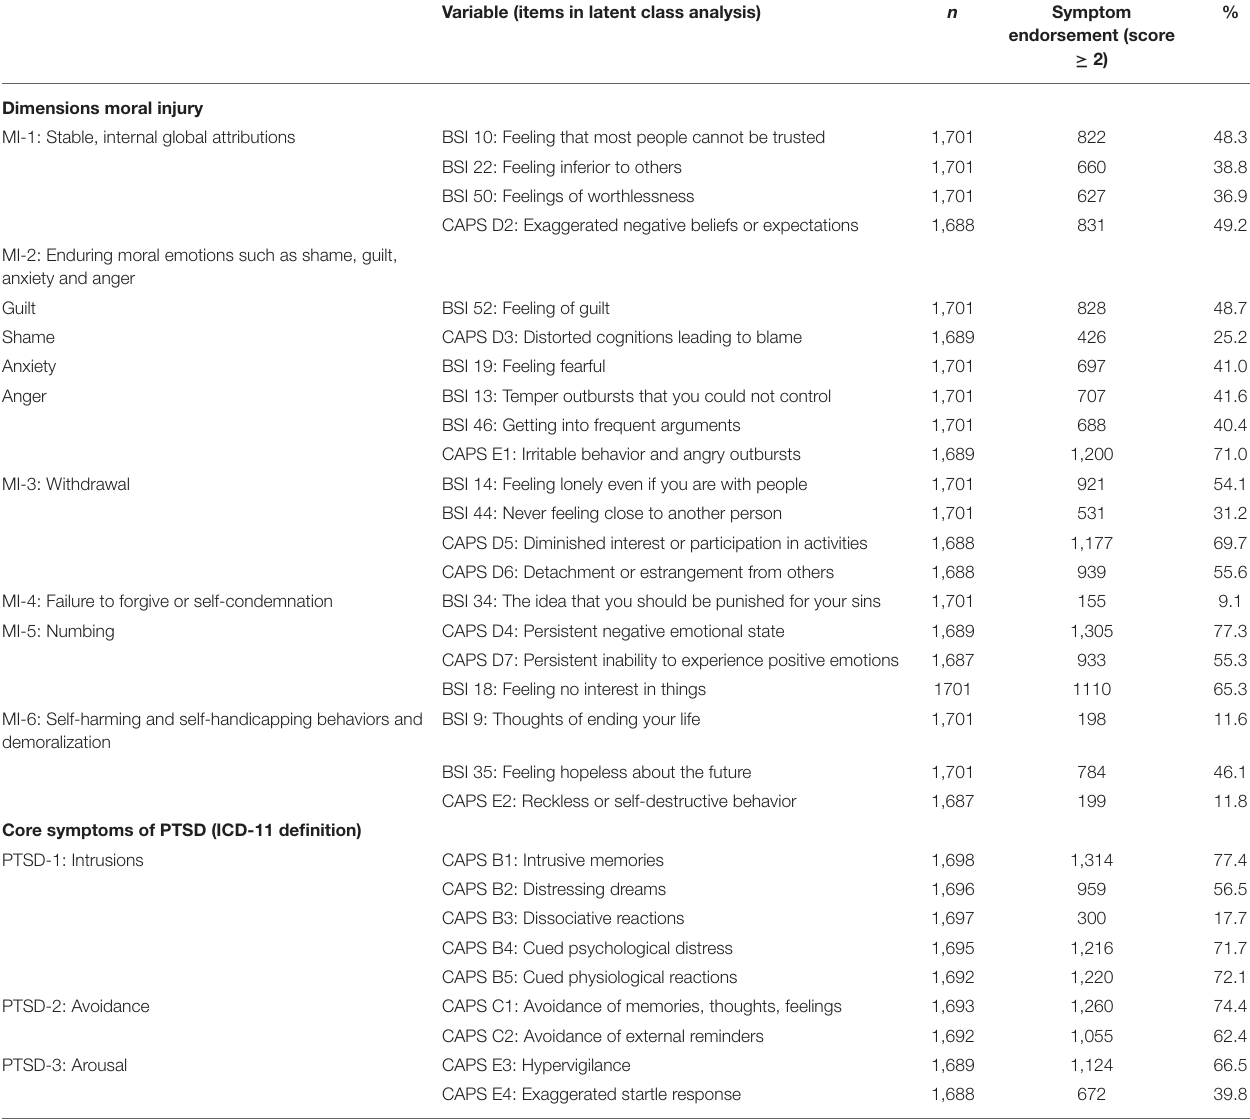
TABLE 2 | Description of the elements of MI and PTSD and the matching items from the BSI and the CAPS-5. Variable (items in latent class analysis) n Symptom